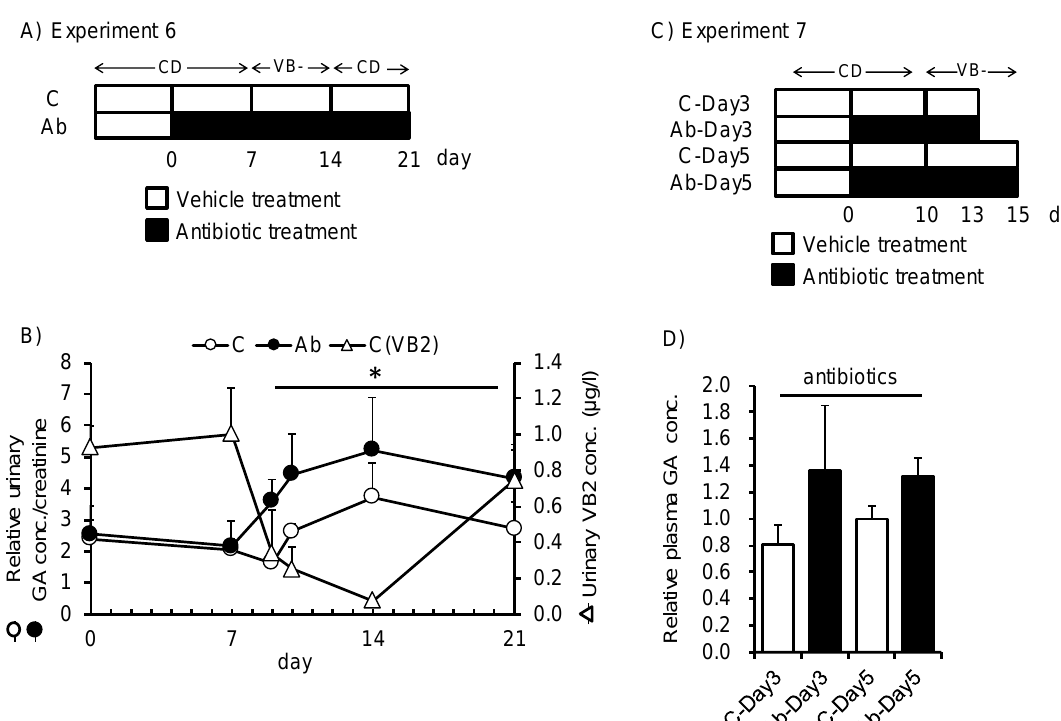
Figure 5. Disruption of gut microbiota following rapid depletion of VB2 in mice fed VB- diet for a short period. ( A , C ) Study design for Experiments 6 and 7. Mice were switched from the control diet to the VB- diet after treatment with antibiotics or the vehicle as a control. Urine or plasma samples were obtained over the indicated time period. ( B ) Time-dependent changes in creatinine-adjusted urinary GA concentration (white and black circles indicate the control and antibiotics-treated mice, respectively) or urinary VB2 concentration (white triangle in the control group). ( D ) Relative concentration of GA in plasma at different time points. Repeated measured ANOVA was used to determine the differences in each group (n = 3). * indicates p < 0.05. Two-way ANOVA was used to determine the effect of time, antibiotics, and the interaction of the two.